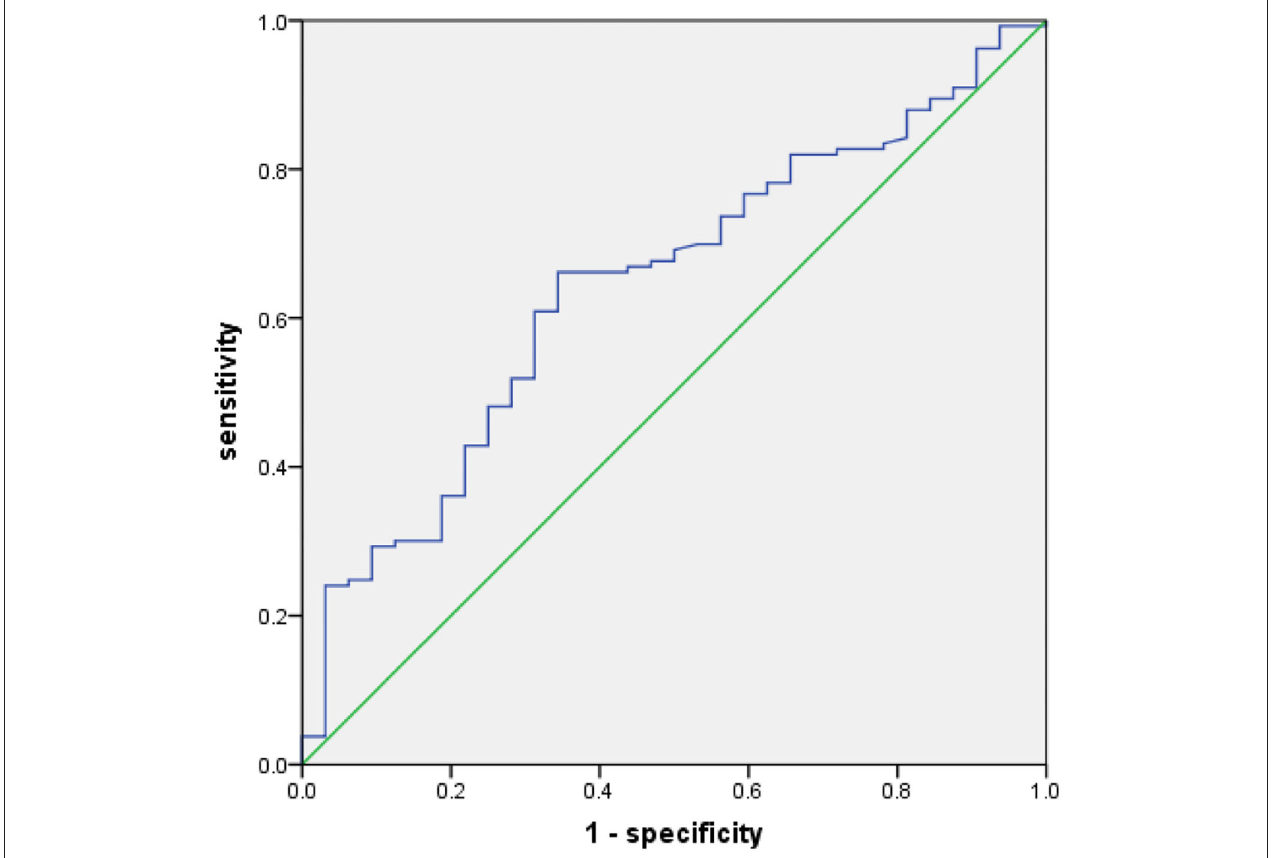
FIGURE 1 | Receiver operating characteristics (ROC) for overall survival (OS) was plotted to calculate the best critical value for prognostic nutritional index